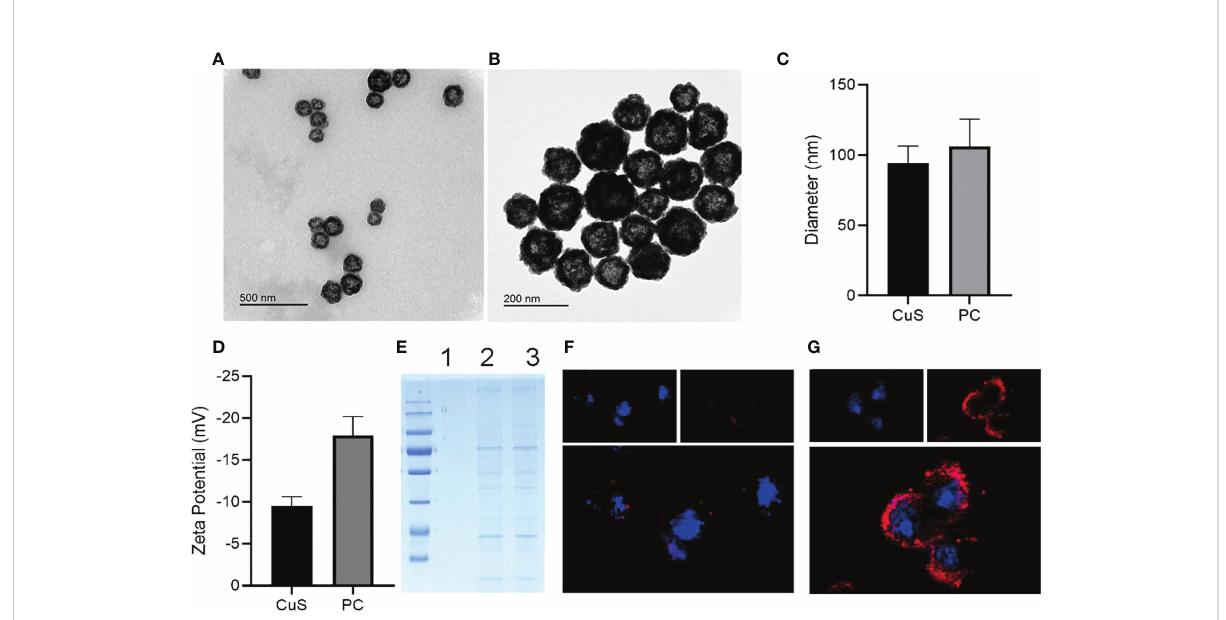
FIGURE 1 TEM images of CuS (A) and PC (B) . Zeta diameter (C) and potentials (D) of CuS and PC. SDS-pages of CuS (1), platelet cell membrane (2) and PC (3) (E) . CLSM images of CT 26 incubated with CuS (F) and PC (G) ; cell nuclei was stained with DAPI and CuS, while PC was stained with DiL.